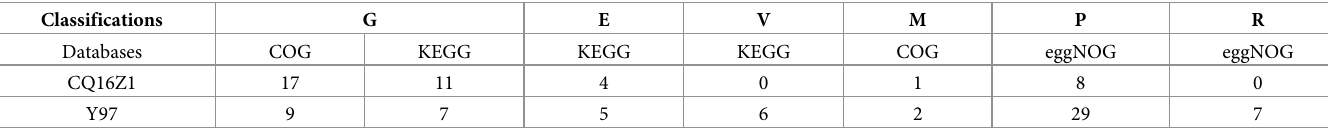
G: Carbohydrate metabolism, E: Environmental information processing, V: Metabolism of cofactors and vitamins, M: Cell wall/membrane/envelope biogenesis, P: Phage related genes, R: Drug resistance related